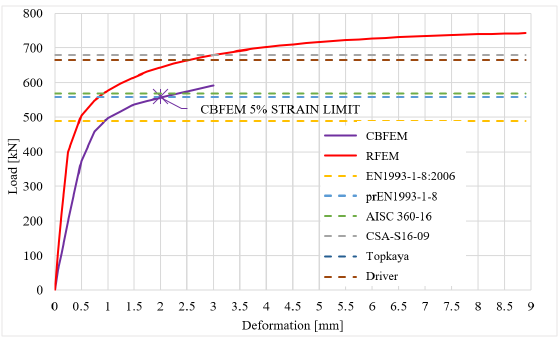
Figure 15. Comparison of RFEM, CBFEM and analytical models for specimen T2.